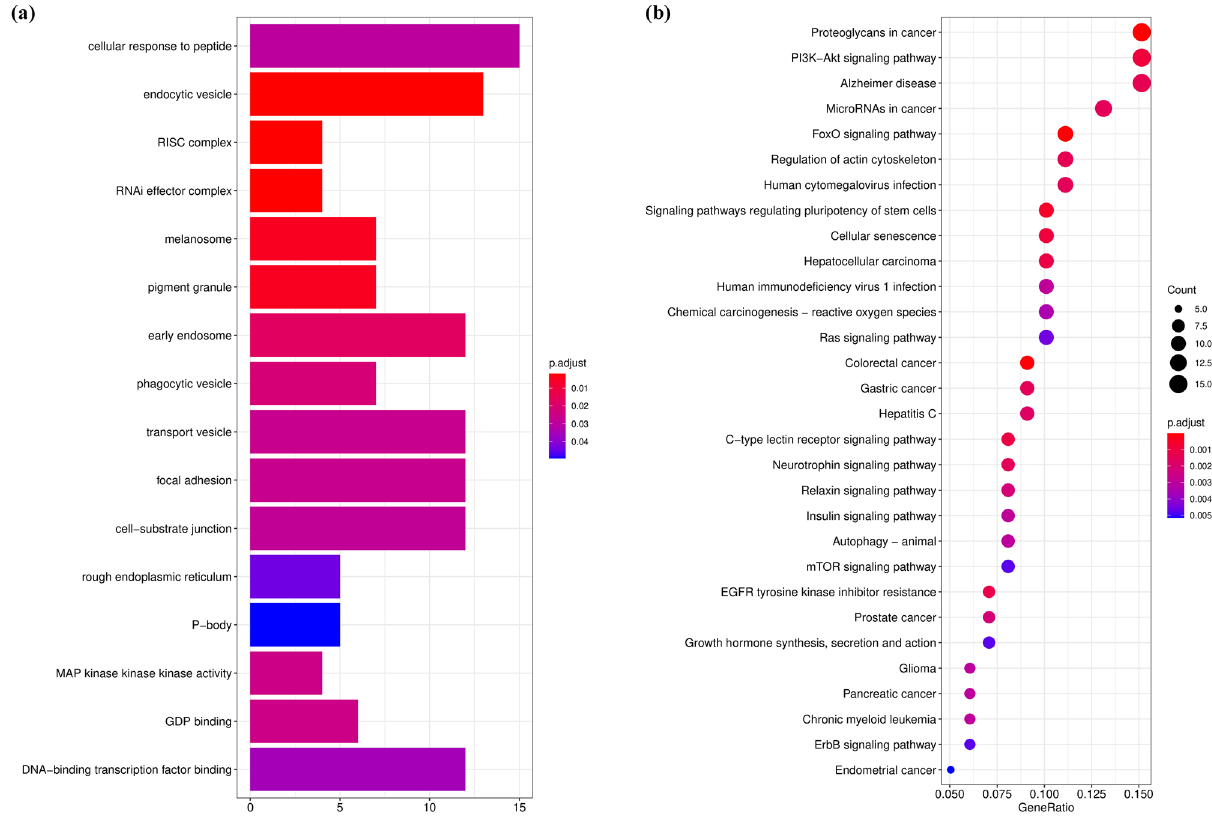
Figure 6: Functional enrichment analysis of consensus genes. ( a ) Bar plot graph for GO pathways ( the longer bar means the more genes enriched, and the increasing depth of red means the di ff erences were more obvious ) . ( b ) Bubble graph for KEGG enrichment ( the bigger bubble means the more genes enriched, and the increasing depth of red means the di ff erences were more obvious; q - value: the adjusted P - value )